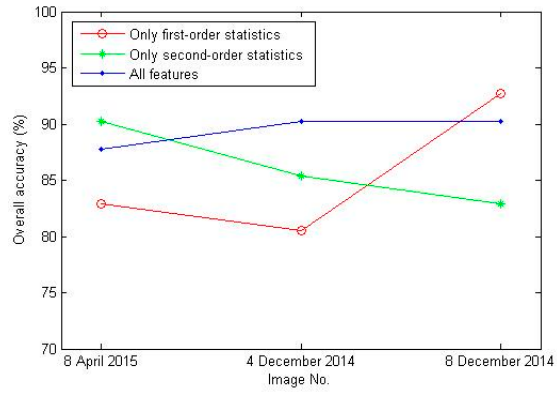
Figure 16. Overall accuracy of the classification results of different images with different features.